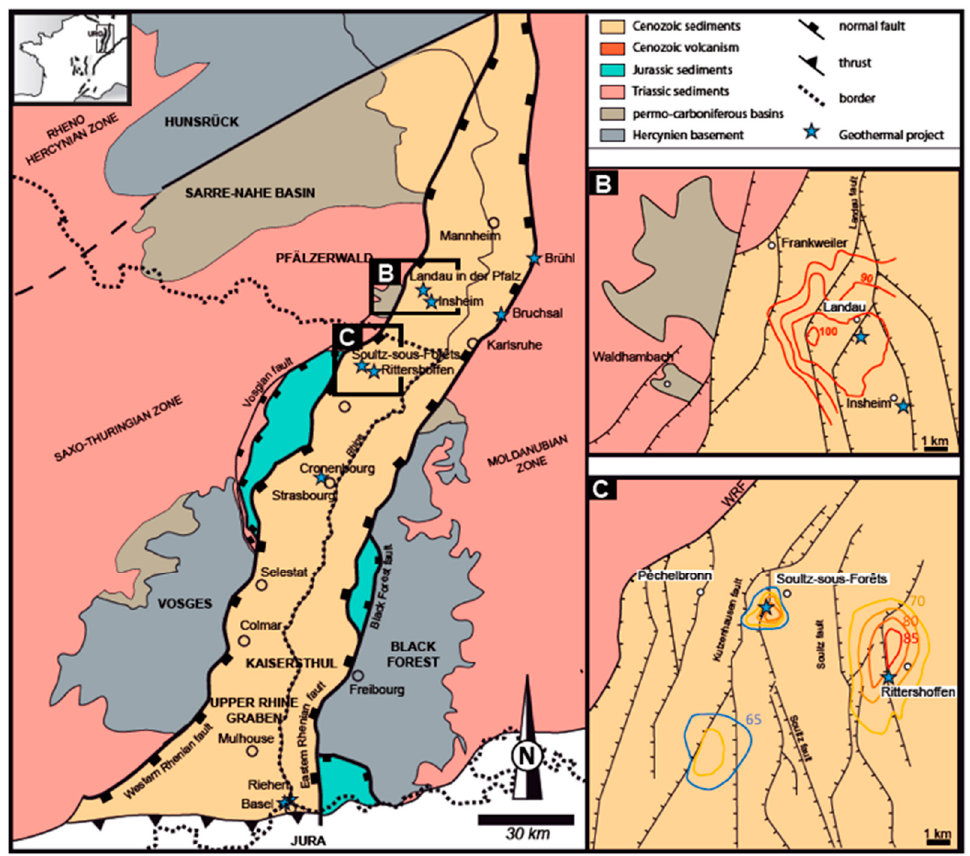
Figure 2. Map of thermal anomalies. Location and simplified geology of the Upper Rhine Graben. Coloured lines indicate isotherms ranging from 50 °C (blue line) to 130 °C (red line) at 1500 m depth. Modified after [17].